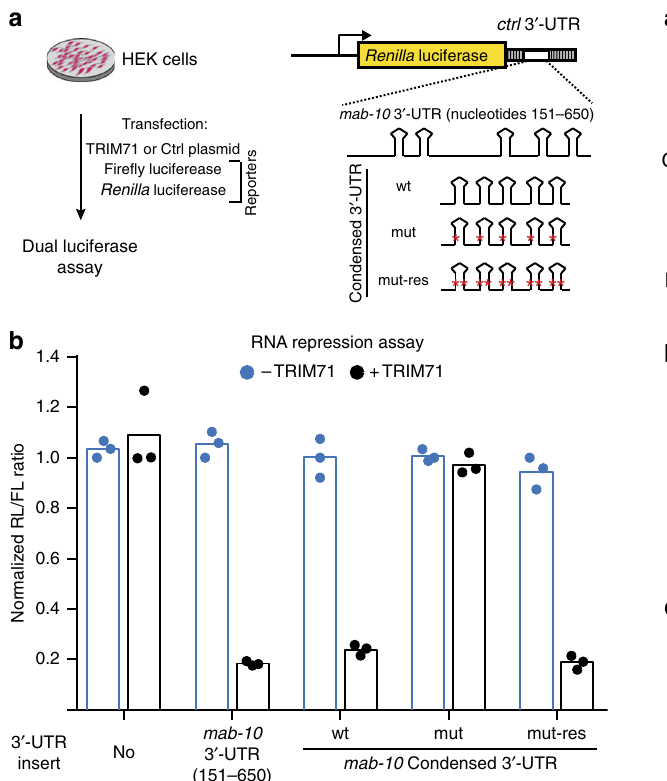
Fig. 3 HsLIN41 recognizes C. elegans RNA stem-loops. a Schematics describing the luciferase assay and reporters used in this assay. 3 ′ -UTR inserts transplanted into the RL ( Renilla luciferase) construct are shown. b HsLIN41 speci fi cally downregulated Renilla luciferase (RL) activity when sequences containing the SLs (from either mab-10 3 ′ -UTR (151-650 nt) or mab-10 condensed SL 3 ′ -UTR) were transplanted into a control, unregulated 3 ′ -UTR. The mab-10 condensed 3 ′ -UTR, with stem-disrupting mutations (mut), was not repressed by HsLIN41. Mutations that restored the SLs (mut-res) also restored the repression. Bars in the graph represent the mean between three biological